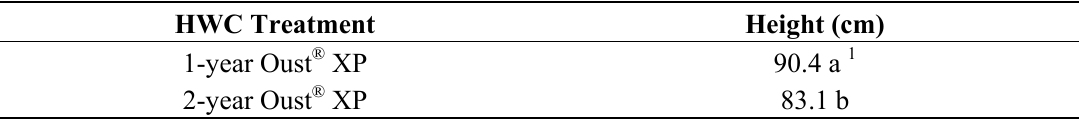
Table 1. Average height of swamp chestnut oak by herbaceous weed control (HWC) regime planted on three Mississippi sites,